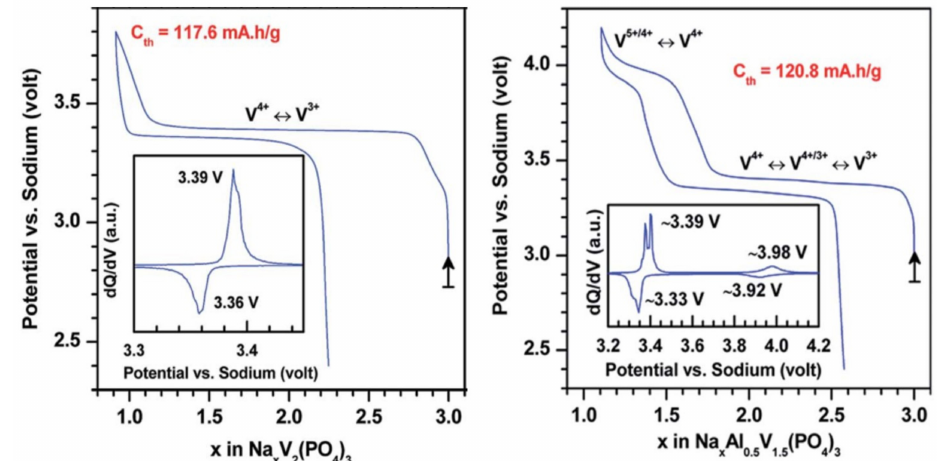
Figure 6. High voltage signature of Nasicon Na 3 V 2 (PO 4 ) 3 and Na 3 V 1.5 Al 0.5 (PO 4 ) 3 , adapted from ref. [39]. Reproduced from Ref. [39] with permission from the Centre National de la Recherche Scientifique (CNRS) and The Royal Society of